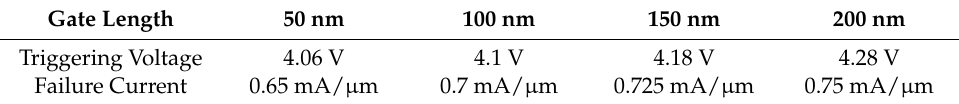
Figure 10. Contour plots of lattice temperatures in TFETs under TLP current density of 0.5 mA/ μ m with different DOP/SOP values: ( a ) DOP = SOP = 100 nm and ( b ) DOP = SOP = 300 nm. Table 1. Triggering voltages and failure currents with different gate lengths.